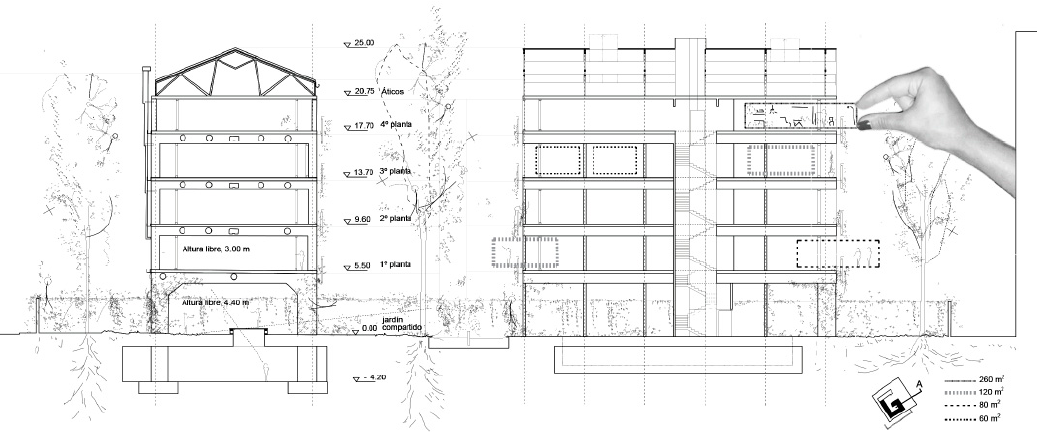
Figure 3. Project section at Ángel Muñoz 22 in Arturo Soria, Madrid. The concrete structure on the perimeter of the continuous balcony allows the free distribution of the interior of the dwellings. Source: Author’s drawing (De Jorge-Huertas 2019a).